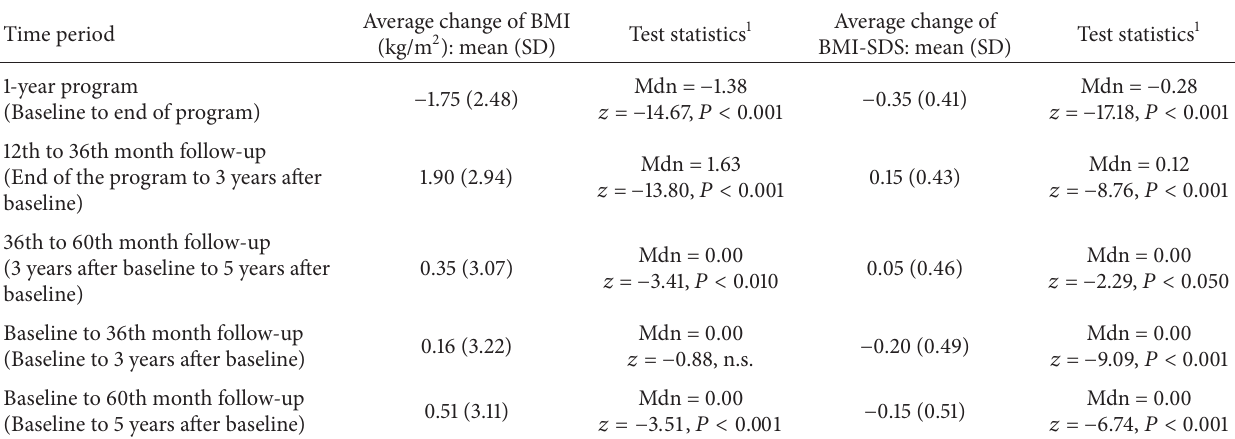
Table 1: Mean differences in BMI and BMI-SDS from baseline to the end of the 1-year program and to 3- and 5-year follow-up (mean (SD); 𝑁 = 596 ; baseline observation carried